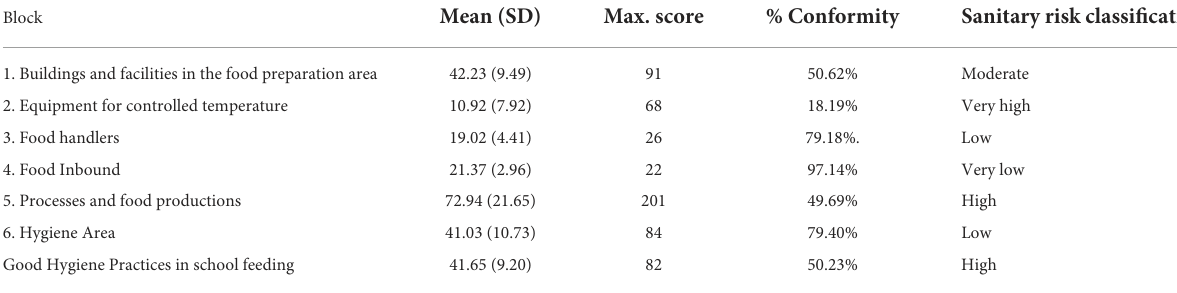
TABLE 1 The sanitary conformity of different areas of the food service facilities of the schools.